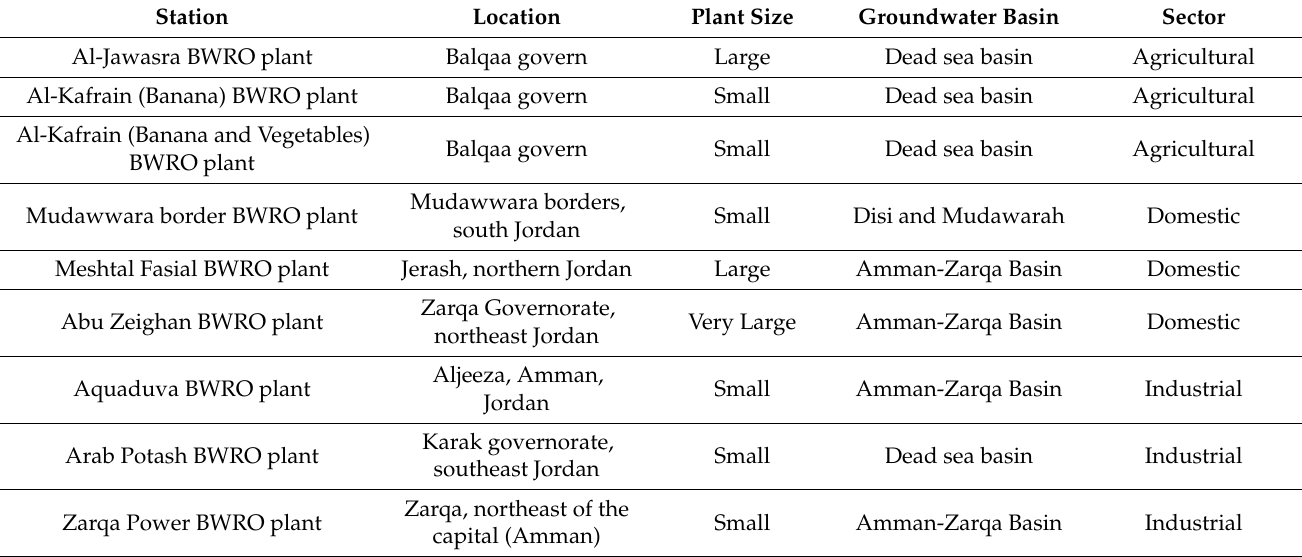
Table 1. Details of the Surveyed BWRO Desalination